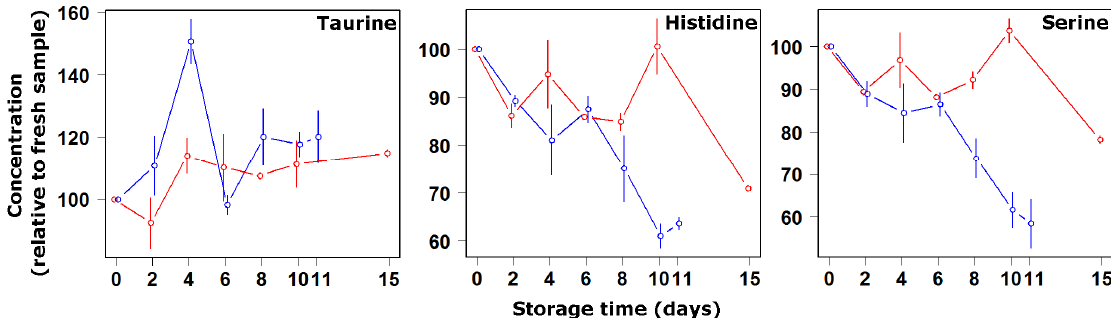
Figure 2. Concentration changes relative to fresh samples of taurine, histidine and serine during storage at 4 °C (blue symbols and lines) and on ice (red symbols and lines).